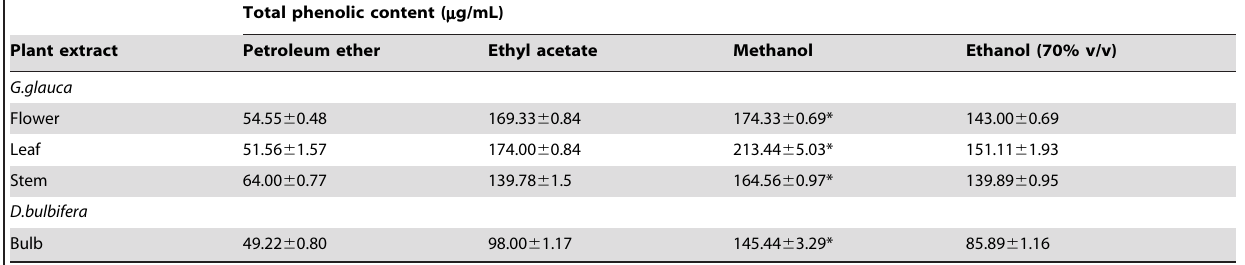
Total phenolic content ( m